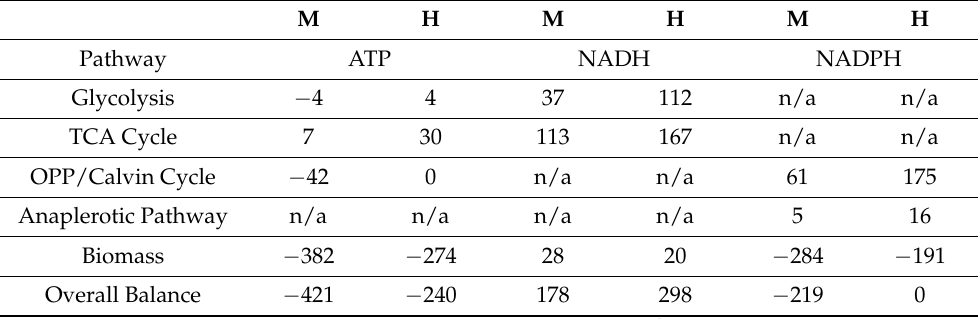
Table 1. A comparison of the energy molecule production and consumption from different pathways. M H M H M